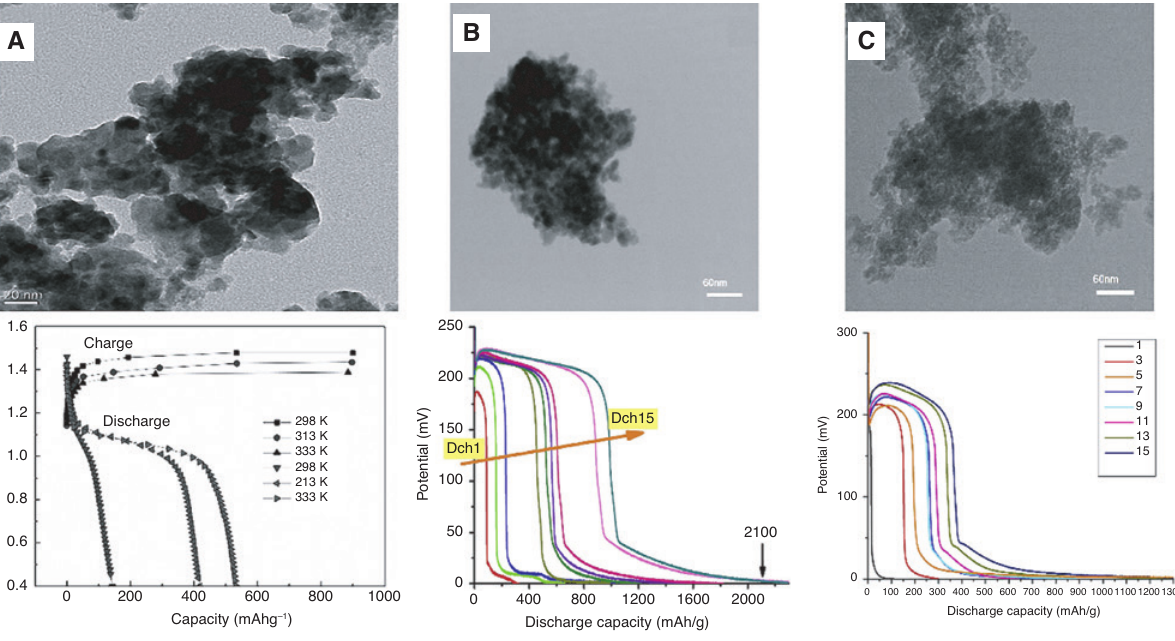
storage and their discharge capacities. 2